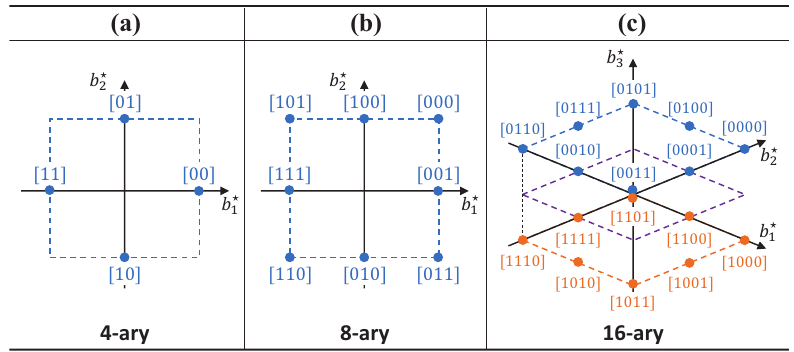
Figure 5. Example of multidimensional mapping function. ( a ) K 1 = 2, M = 4; ( b ) K 1 = 2, M = 8; ( c ) K 1 = 3, M =